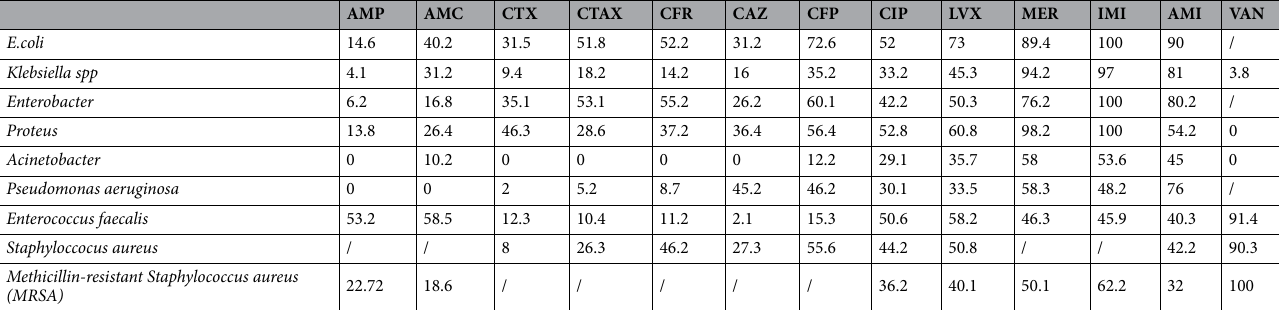
Table 3. Antibiotics susceptibility patterns of isolated uropathogens (% sensitivity). AMP Ampicillin, AMC Amoxicillin/clavulanic acid, CTX Cefotaxime, CTAX Ceftriaxone, CFR Cefuroxime, CAZ Ceftazidime, CFP